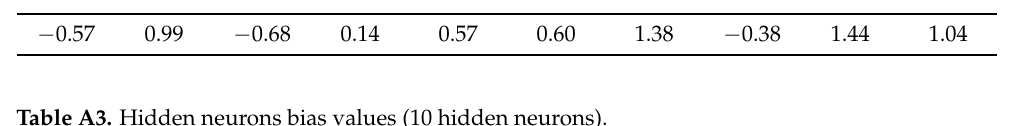
Table A2. Output layer weights (10 hidden neurons × 1 output (CC)).